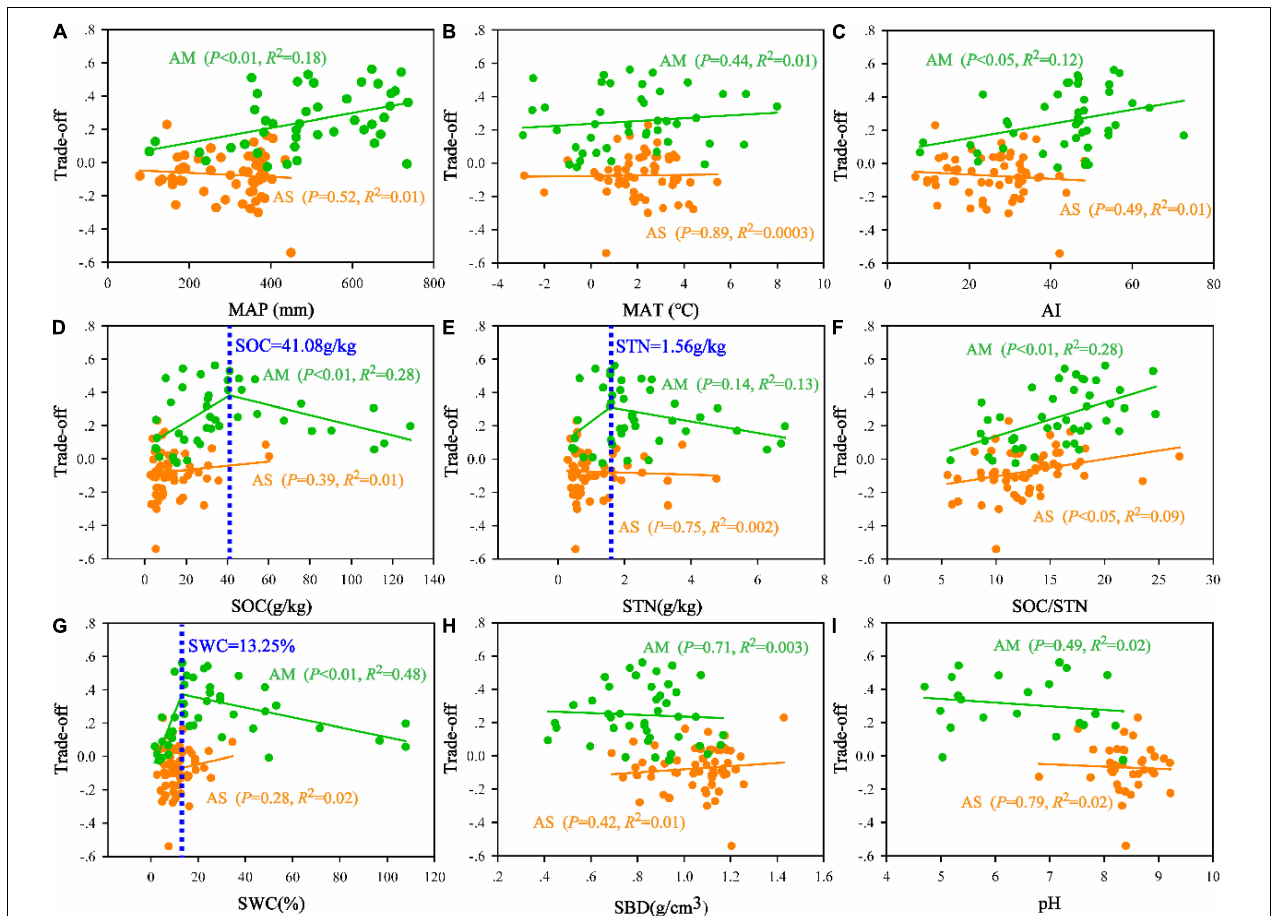
FIGURE 6 | Relationships of the trade-off with (A) mean annual precipitation (MAP), (B) mean annual temperature (MAT), (C) aridity index (AI), (D) soil organic carbon (SOC), (E) soil total nitrogen (STN), (F) the ratio of SOC to STN (SOC/STN), (G) soil water content (SWC), (H) soil bulk density (SBD), and (I) soil pH (pH) in alpine steppe (AS) and alpine meadow